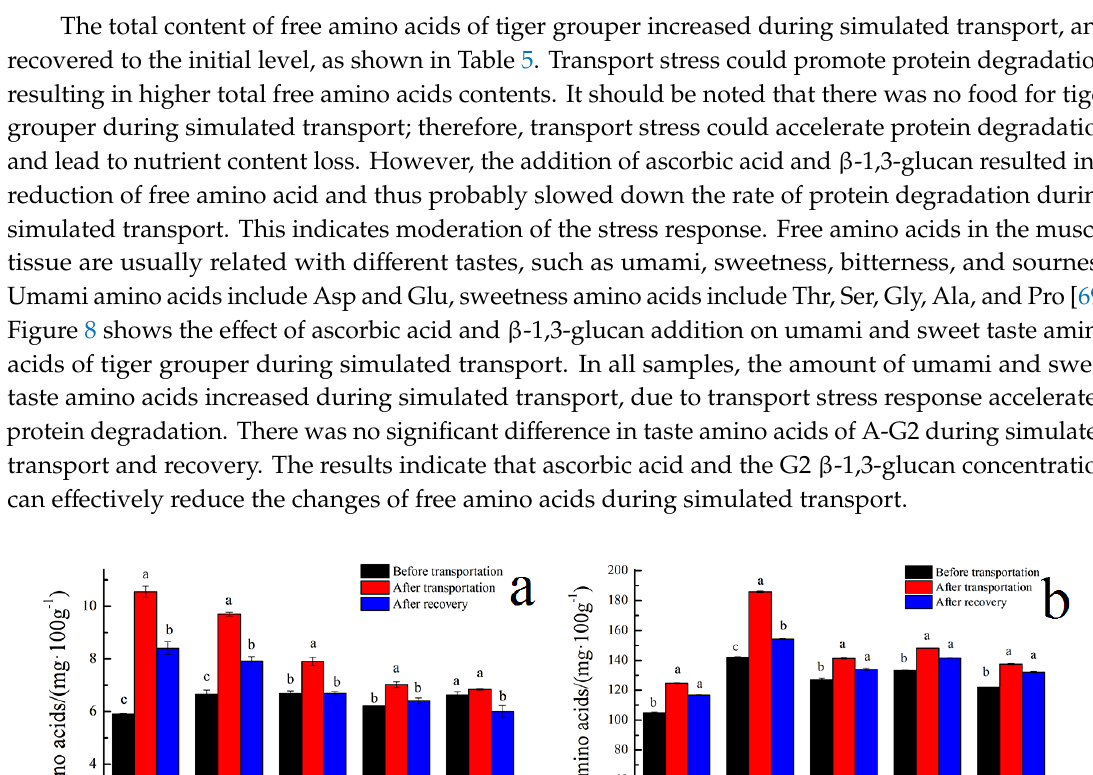
Table 6. Effect of ascorbic acid and β-1,3-glucan addition on nucleotides of tiger grouper during simulated transport in water.